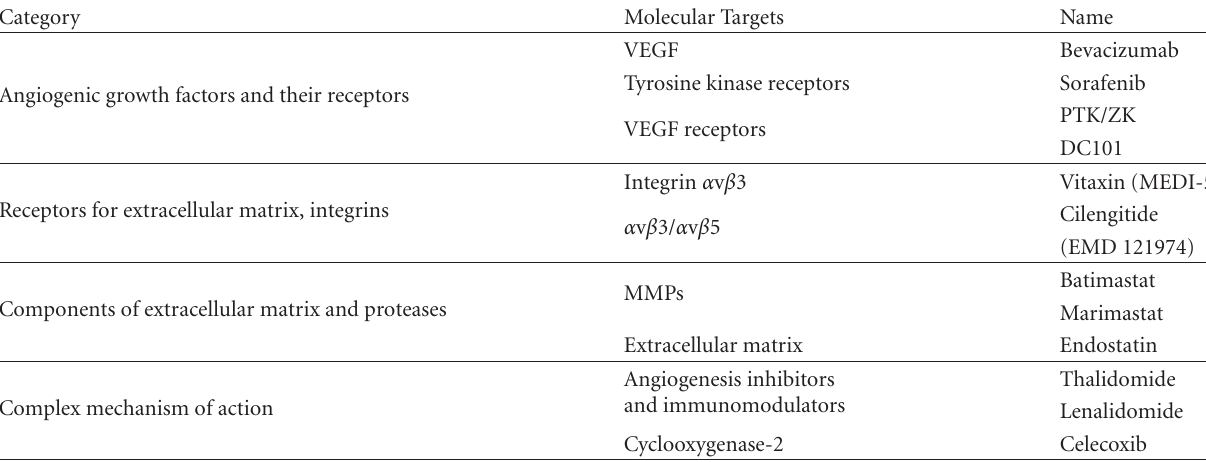
Table 1: Molecular targets of antiangiogenic